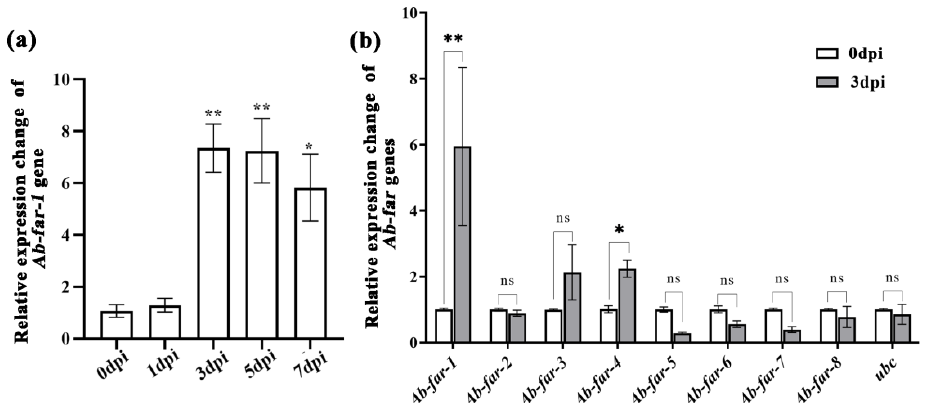
Figure 1. Expression changes of Ab-far genes in the process of nematode infection. ( a ) The expression changes of Ab-far-1 gene during RWTN infection. ( b ) The expression changes of Ab-far genes (Ab-far-1 to Ab-far-8) 3 days post-infection (dpi). To determine the silence efficiency of gene, the gene expression from 0 dpi was normalized as 1, and fold change was calculated using the 2 - ΔΔ Ct method to determine a change in expression of the genes of interest. Values are presented as the means ± standard error (SE), n = 9. Asterisks denote significant differences (* p < 0.05, * * p < 0.01; t -test) from the 0 dpi treatment.